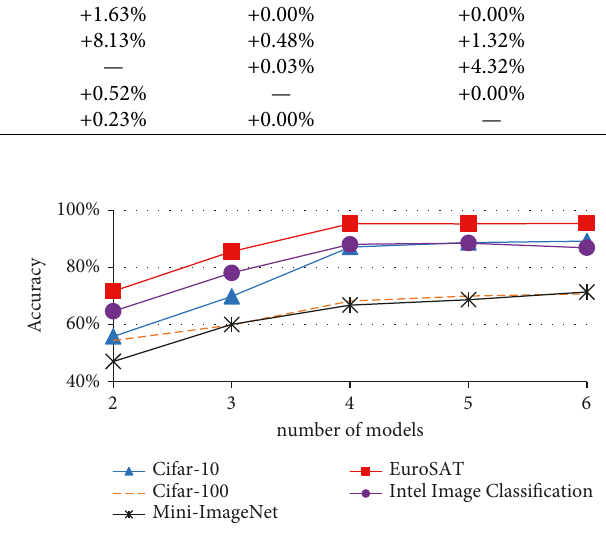
Figure 5: The evaluation on the number of models based on